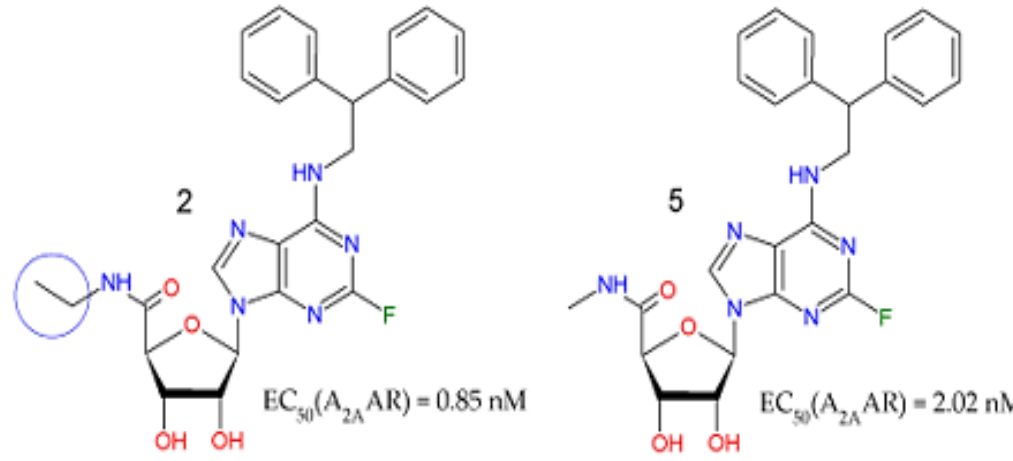
Figure 5. Importance of the hydrophobic feature to A 2A AR agonism, through the methyl e ff